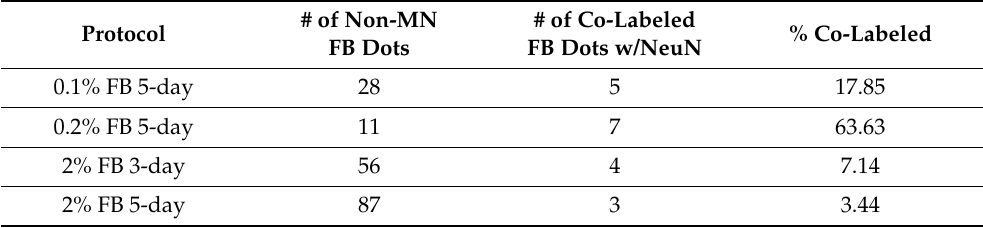
Figure 6. Tracer leakage in 2% FB 3-day protocol. A 60 × image of ( A ) FB labeling, ( B ) NeuN labeling, and ( C ) FB, NeuN, and VAChT labeling. The white arrows indicate non-neuronal structures that are positive for FB+ (in A ) but negative for both NeuN (in B ) and VAChT (in C ). The scale bar represents 20 µ m. Image taken on Olympus FV1000 confocal. Table 2. NeuN Co-labeling Analysis. FB sections from 0.1% FB 5-day, 0.2% FB 5-day, 2% FB 3-day, and 2% FB 5-day were stained with NeuN and VAChT to determine if blue, fluorescent dots were neuronal and/or